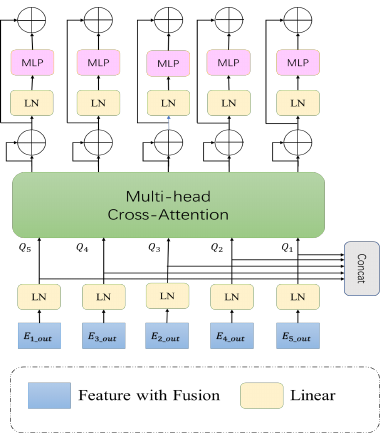
Figure 5. Structure of the CCT